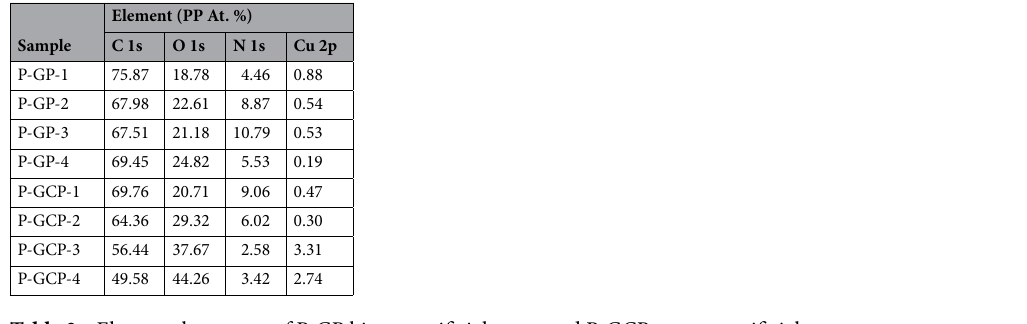
Table 2. Elemental contents of P-GP binary artificial nacre and P-GCP ternary artificial nacre.